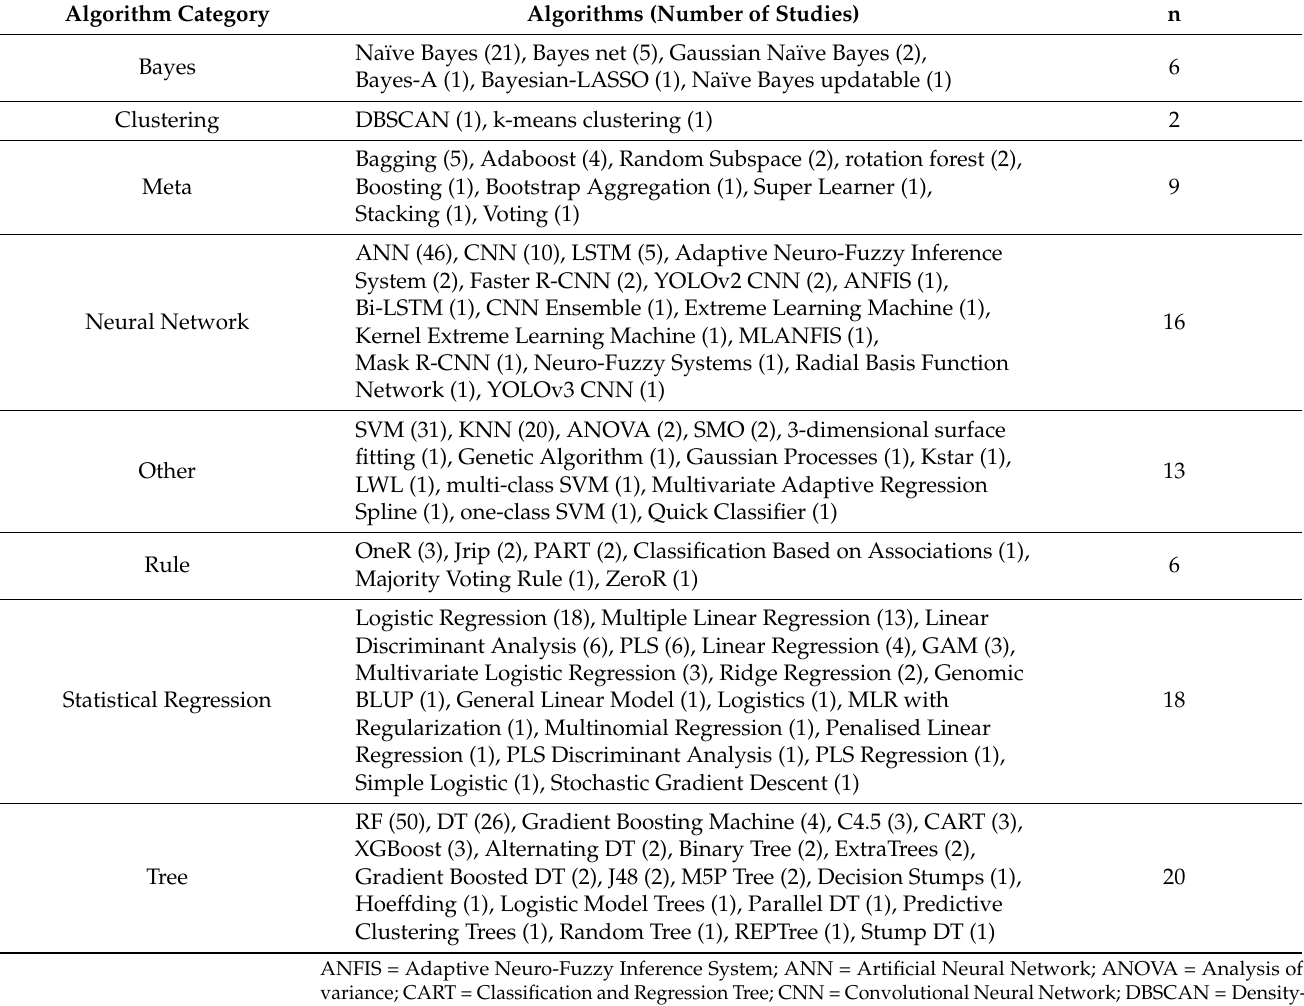
Table A3. Specific algorithms used per algorithm